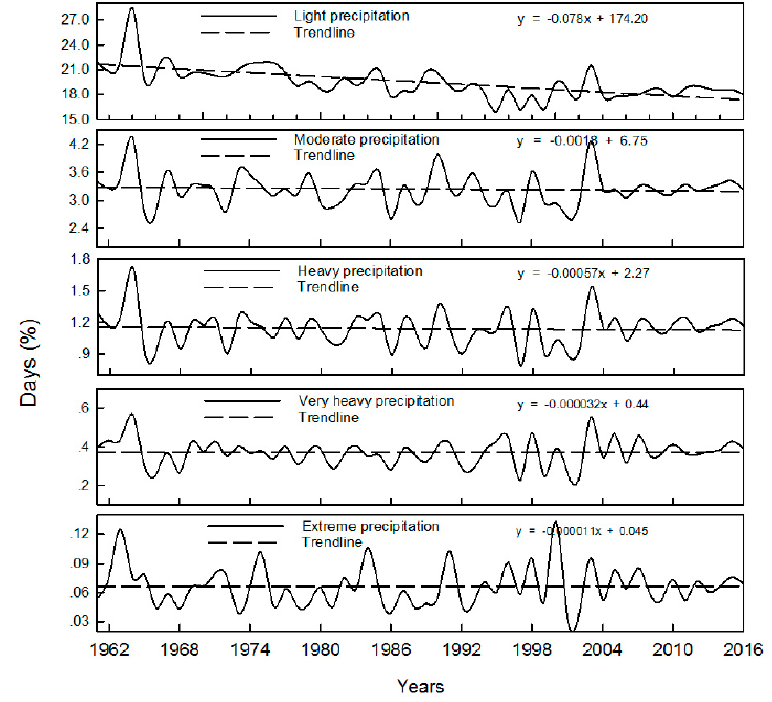
Figure 6. Ratio between rainy days of each grade and the total number of days in a year.